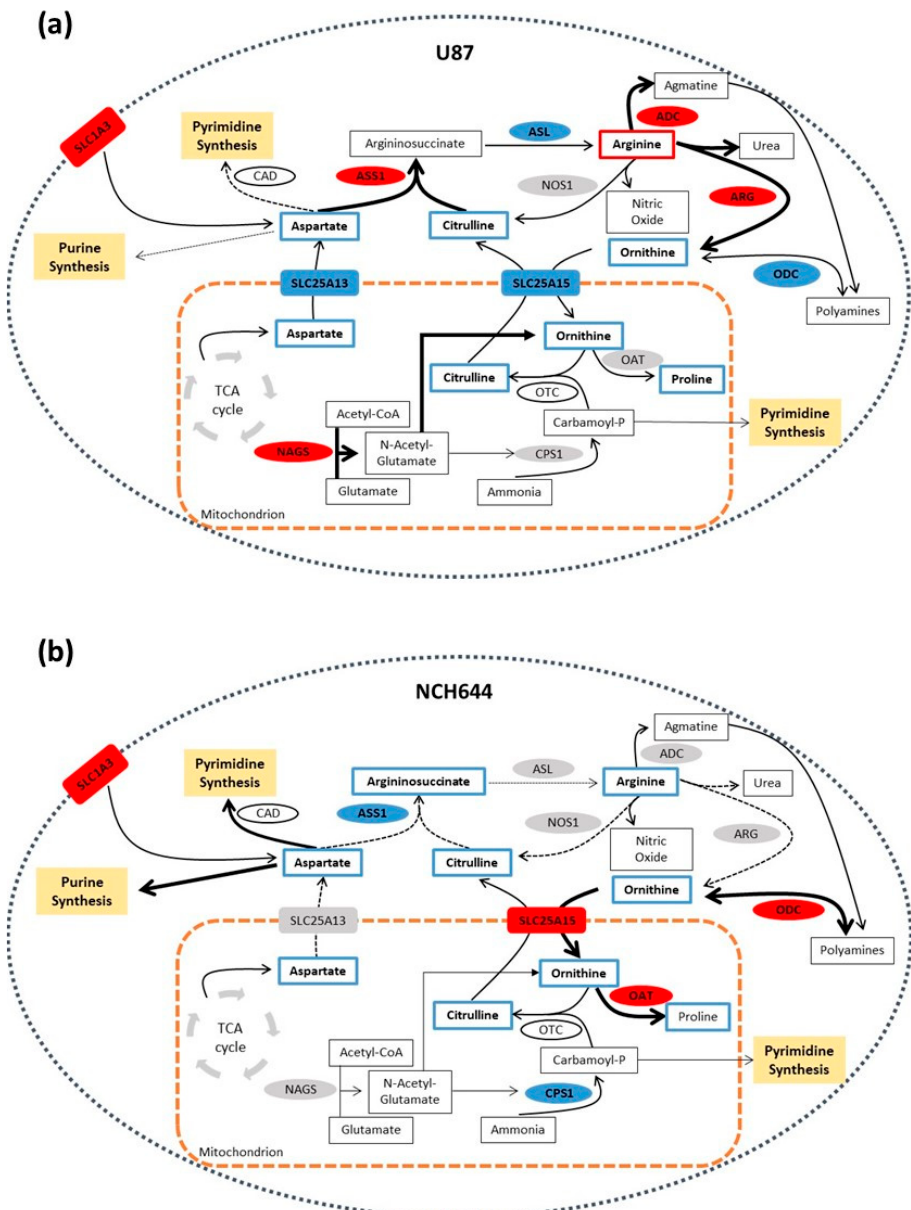
Figure 7. Proposed model of arginine metabolism in U87 and NCH644 neurospheres. ( a ) U87 NS present ASS1 upregulation, pointing towards aspartate shuttling into arginine synthesis. Arginine may then be used by ADC or ARG in the cytoplasm for agmatine and ornithine production, respectively. By upregulating NAGS, ornithine production may be further